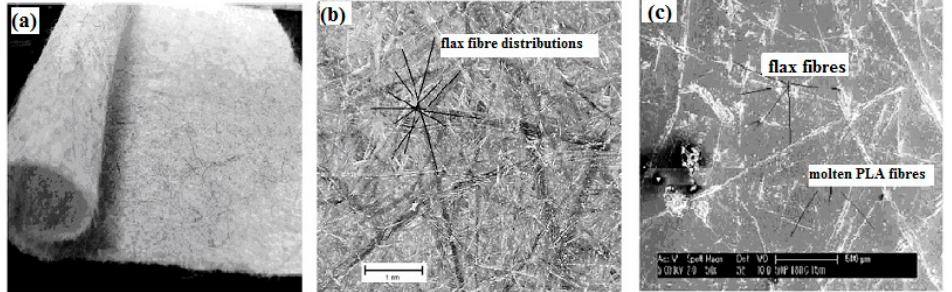
Figure 2. Image of produced flax/PLA nonwoven mat ( a ), flax fiber arrangement within the mat ( b ) and molded composite plaque ( c ).